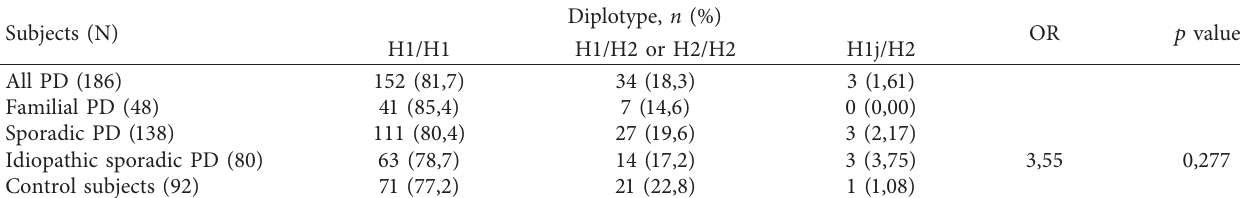
Table 2: Comparison of frequencies of the MAPT diplotypes between PD patients and controls.